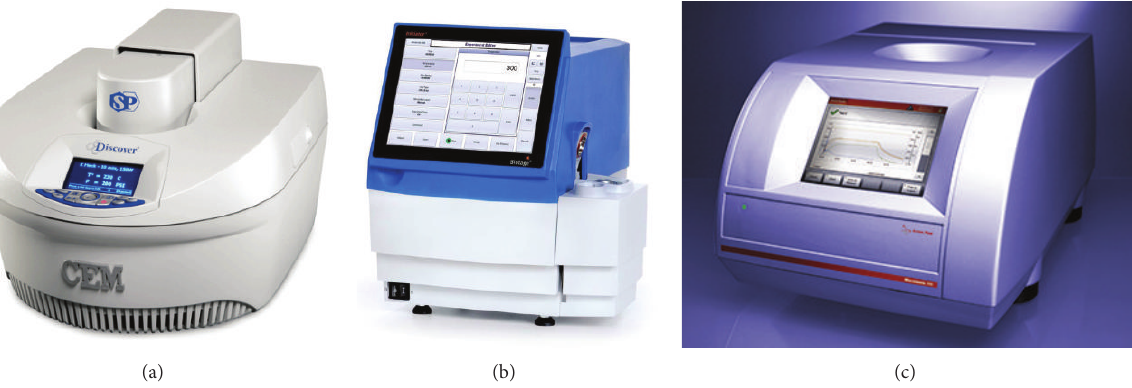
Figure 2: Discover (CEM); Initiator (Biotage); and Monowave 300 (Anton Paar).